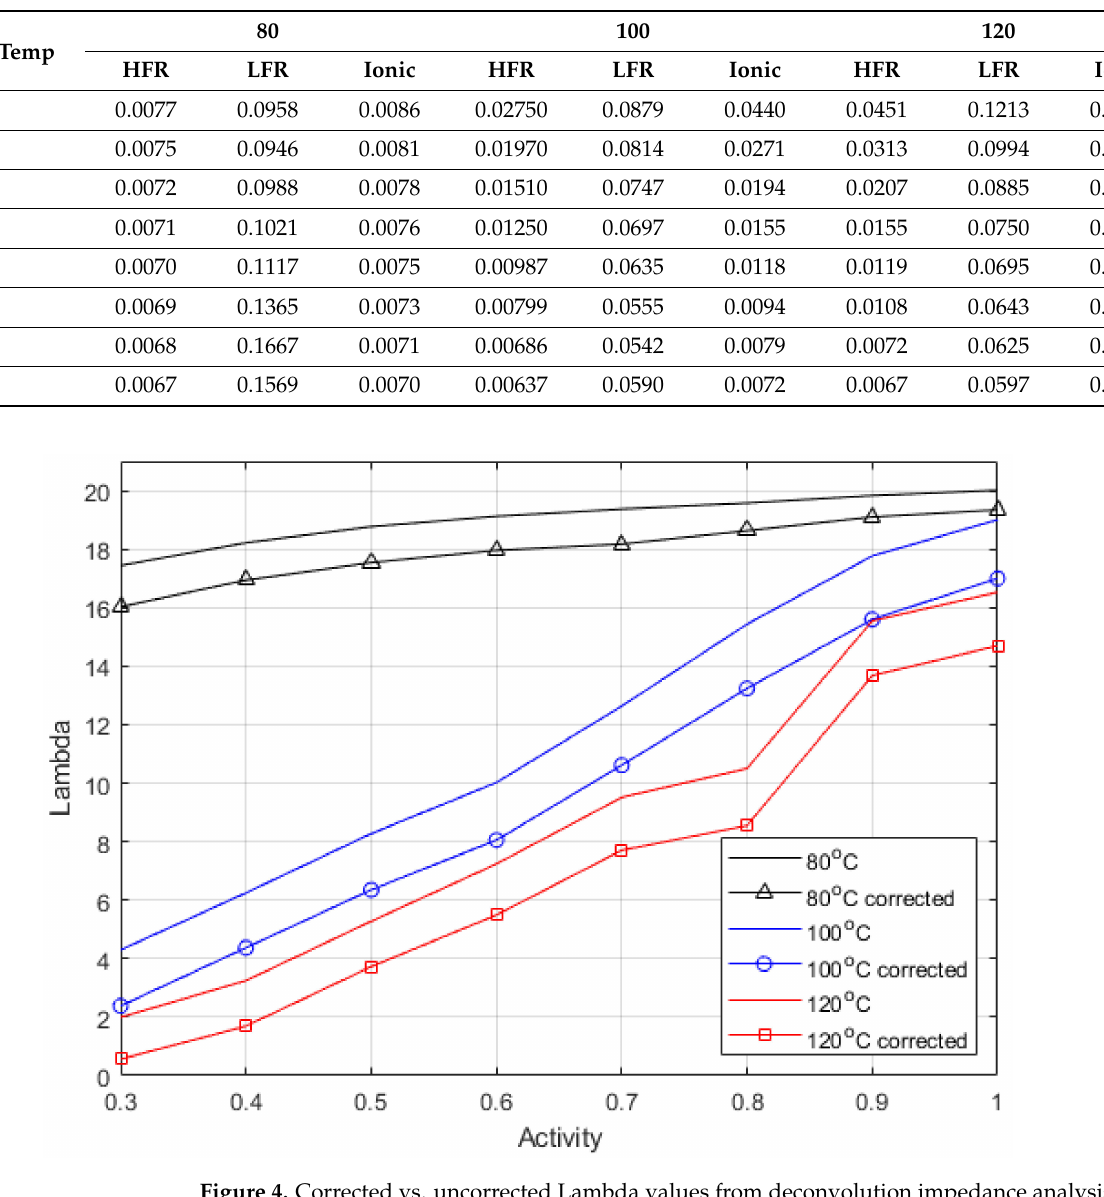
Figure 4. Corrected vs. uncorrected Lambda values from deconvolution impedance